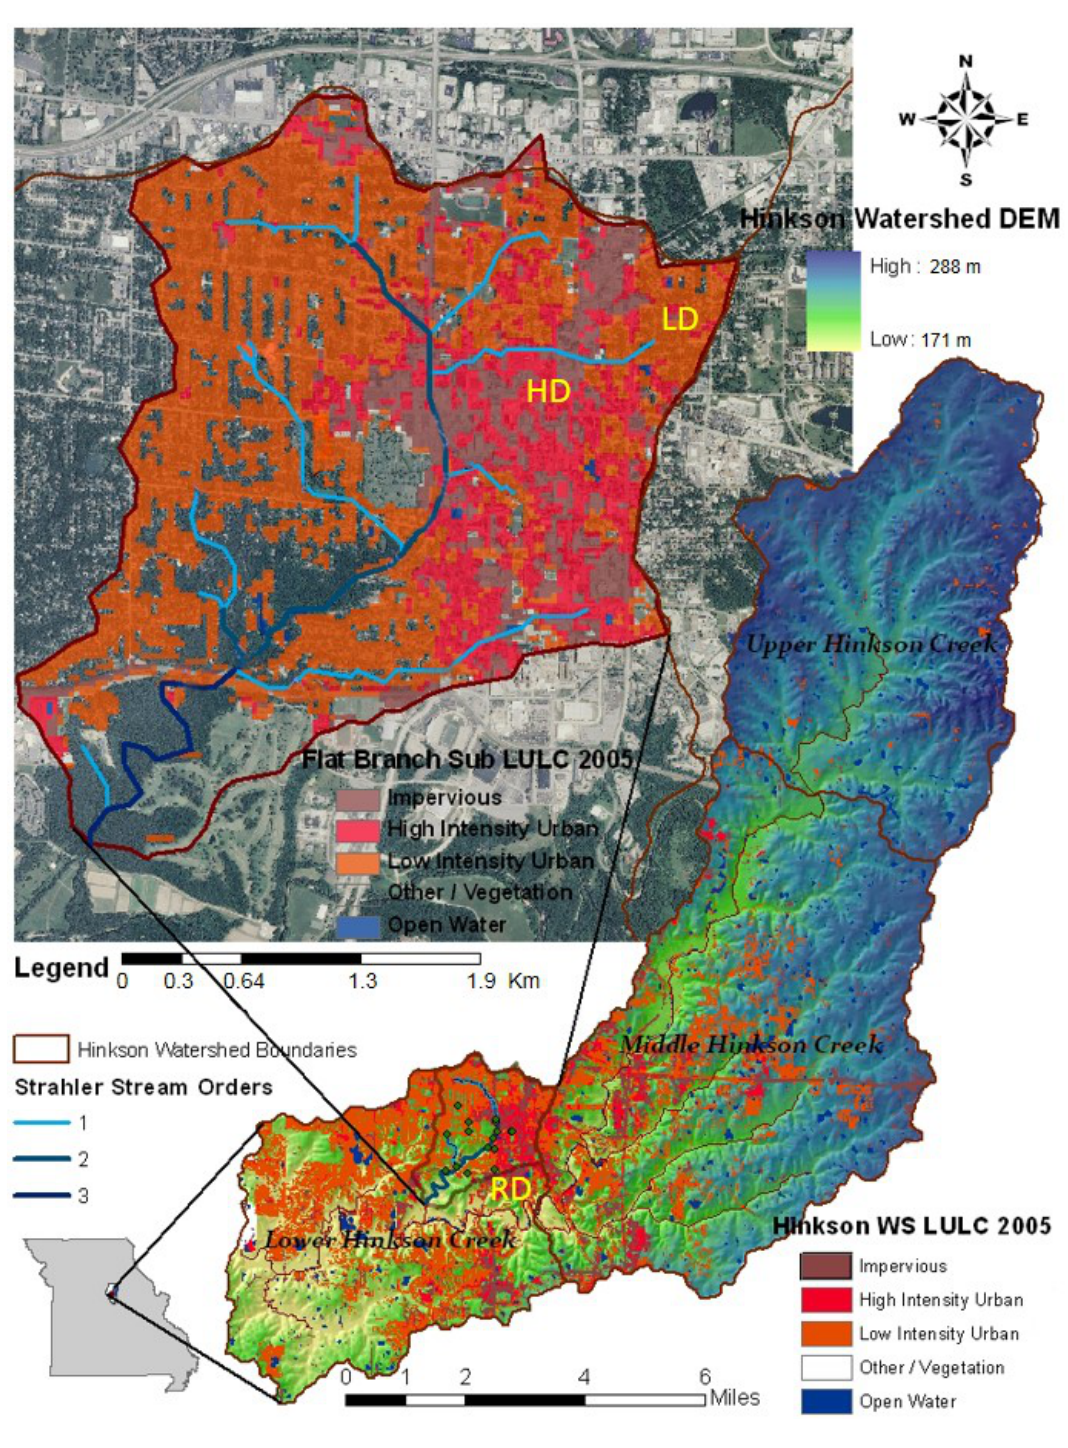
Figure 2. Urban climate monitoring site locations in the City of Columbia, Missouri, USA, where LD = Low Development site, HD = High Development site, and RD = Recent Development site, m = meters, Km = Kilometers. Site land use data and assignations as per MSDIS